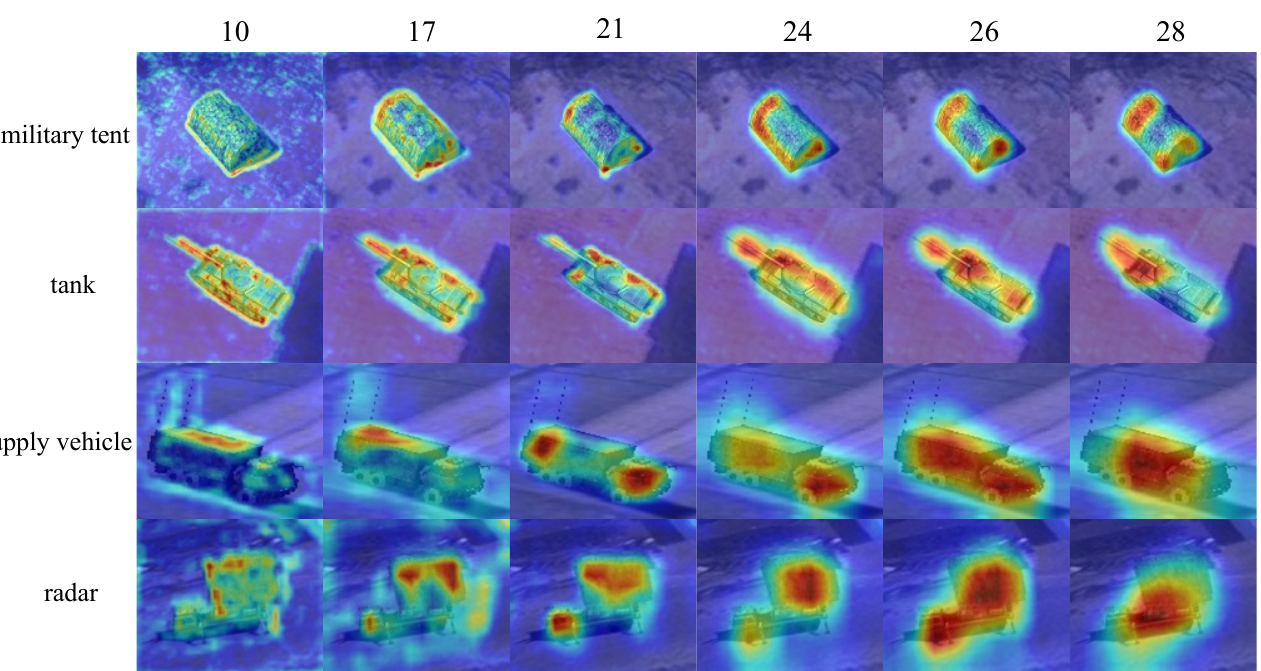
Figure 4. Score-CAM feature visualization for different